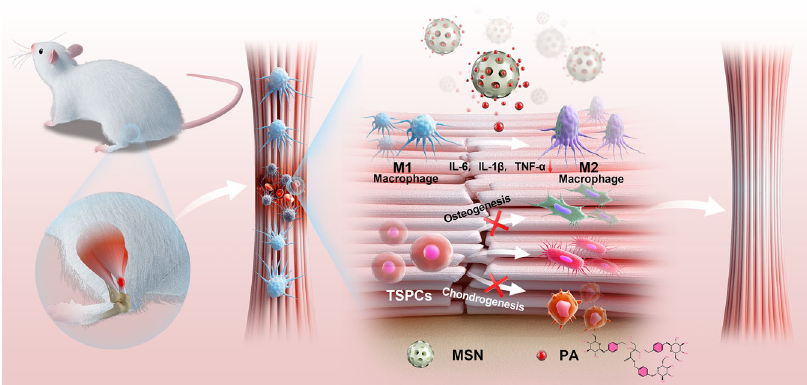
Fig. 7 Schematic illustration of MSN@PA regulating macrophages to promote tendon repair. Sustained delivery of PA by mesoporous silica nanoparticles (MSNs) could almost recover the native tendon ’ s dense parallel-aligned collagen matrix in collagenase-induced tendinopathy by modulating macrophage-mediated immune microenvironment and preventing heterotopic ossi fi